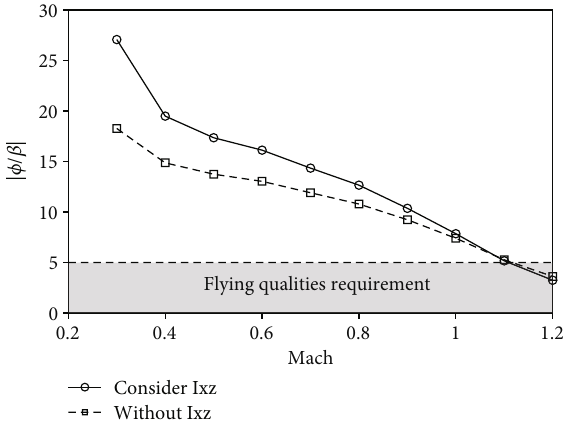
Ixz0.2 Consider Ixz Without Figure 7: Diagram of roll – yaw